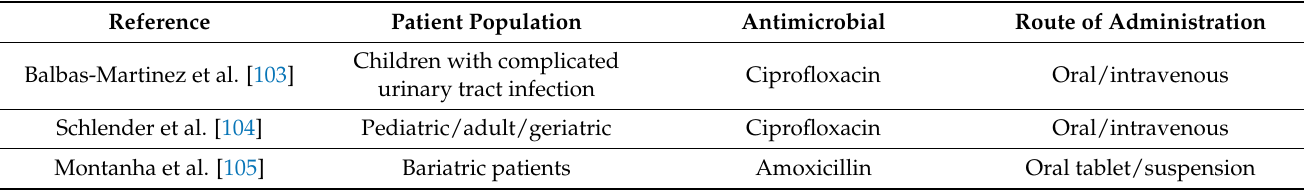
Table 3. PBPK models developed with antimicrobial drugs in special